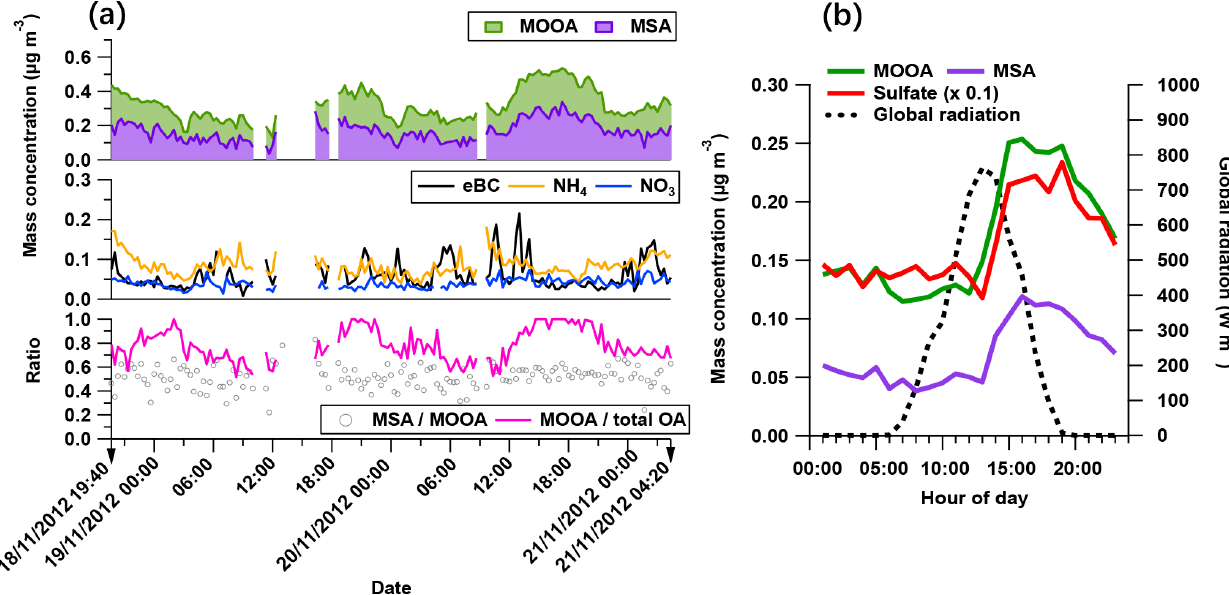
Figure 6. The characteristics of the MOOA-dominating period: (a) time series of MOOA and MSA (top), possibly non-marine species (eBC, NH 4 and NO 3 in middle figure), as well as the ratio between MSA and MOOA and the mass fraction of MOOA in the total OA (bottom). (b) The diurnal variation of MOOA, MSA, sulfate (reduced to one tenth for comparison) and the global radiation.